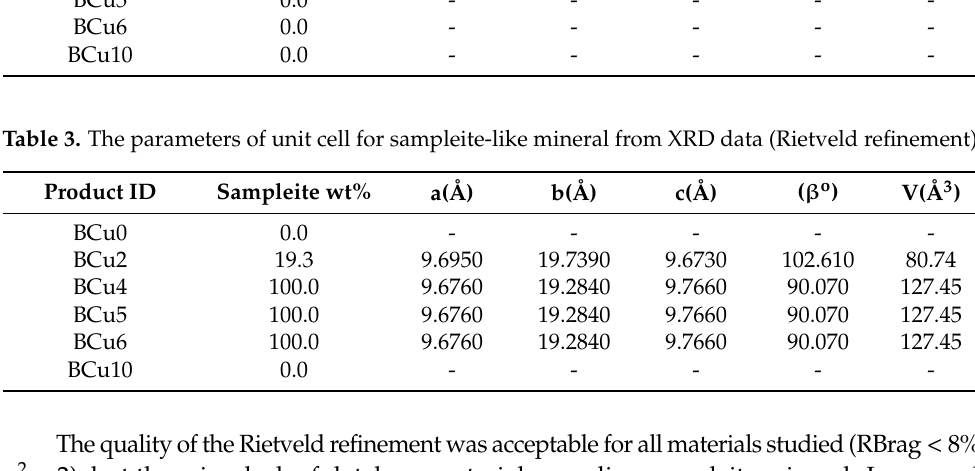
Table 2. The parameters of unit cell for brushite from XRD data (Rietveld refinement). Product